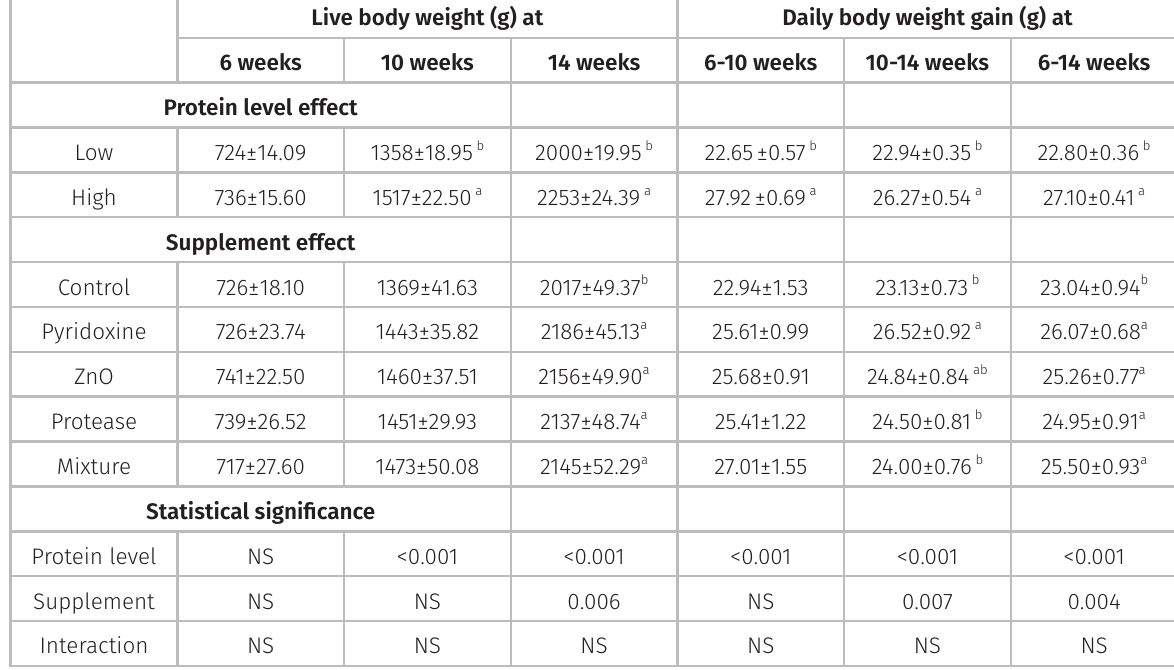
Table II. Live body weight and daily body weight gain (Mean± SE) of New Zealand White rabbits as affected by protein level and tested feed additives.Means in the same column bearing different letters differ significantly